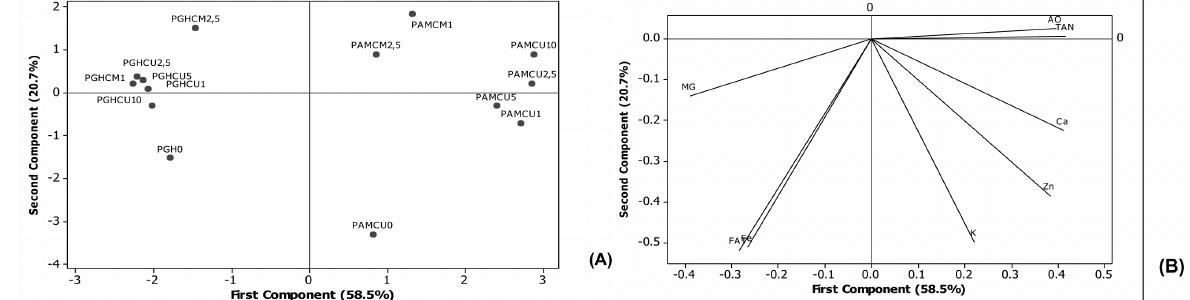
Figure 1. (a) Scores of the first two principal components used to differentiate the heat treatments; (b) Biplots used to indicate the variables that differentiated the treatments in both